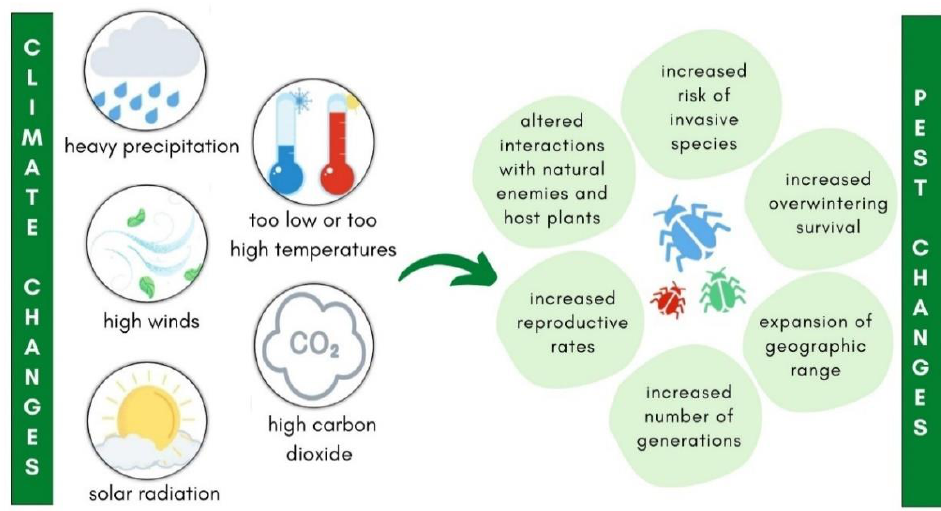
Figure 1. The impact of climate changes on insect pest phenology.